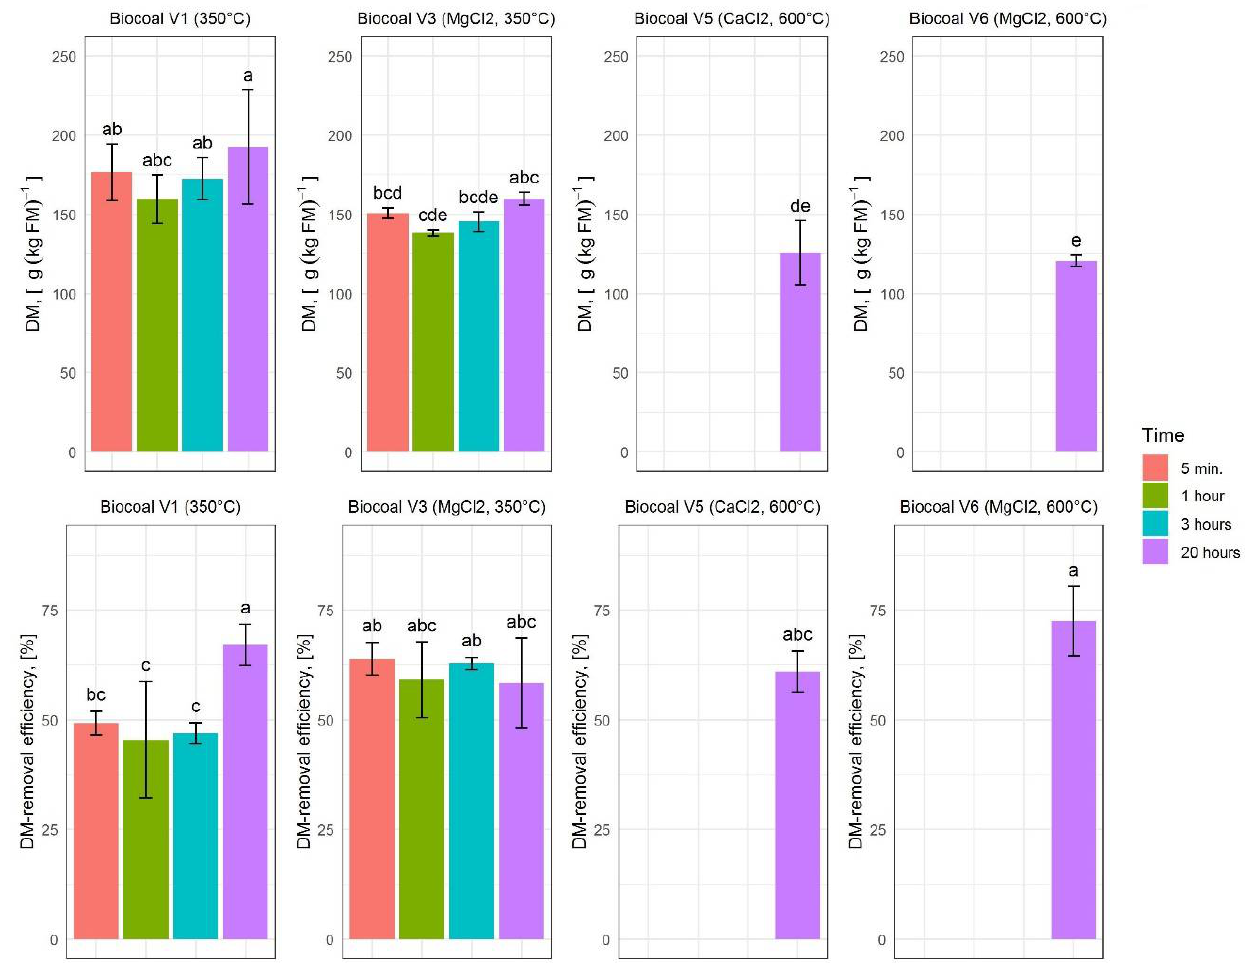
Figure 5. Dry matter (DM) concentration and DM-removal efficiency for the different variants of added biocoal. The upper diagrams show the DM concentration. The lower diagrams show the removal efficiency. Histograms are charted based on the mean values; error bars indicate the varia- bility between the three replications. Lower case letters indicate significant differences according to Tukey test.